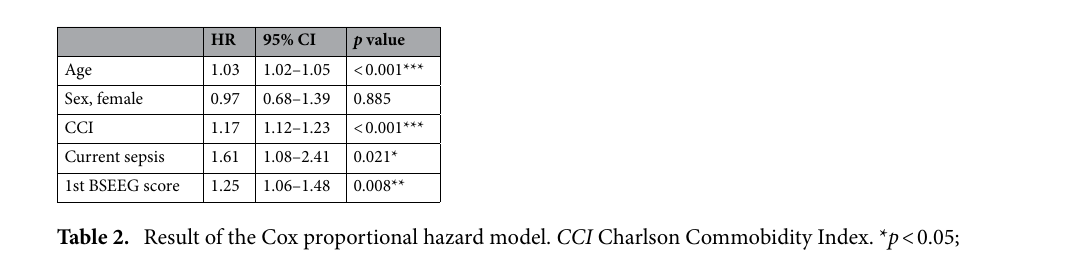
Figure 3. ( A ) Kaplan–Meier survival curve over 365 days by comparing four patient groups based on whether they had current sepsis and/or high BSEEG score (indicative of more slow waves). Log-rank statistic was performed to assess significance of difference in 365-day mortality. ( B ) 28-day mortality by comparing four groups based on whether they had current sepsis or and/or high BSEEG score. Logistic regression including sepsis status, BSEEG grouping, and an interaction between two variables was performed to assess significance of difference in 28-day mortality. * p < 0.05, *** p < 0.001, sepsis (−): sepsis-negative, sepsis (+): sepsis-positive.